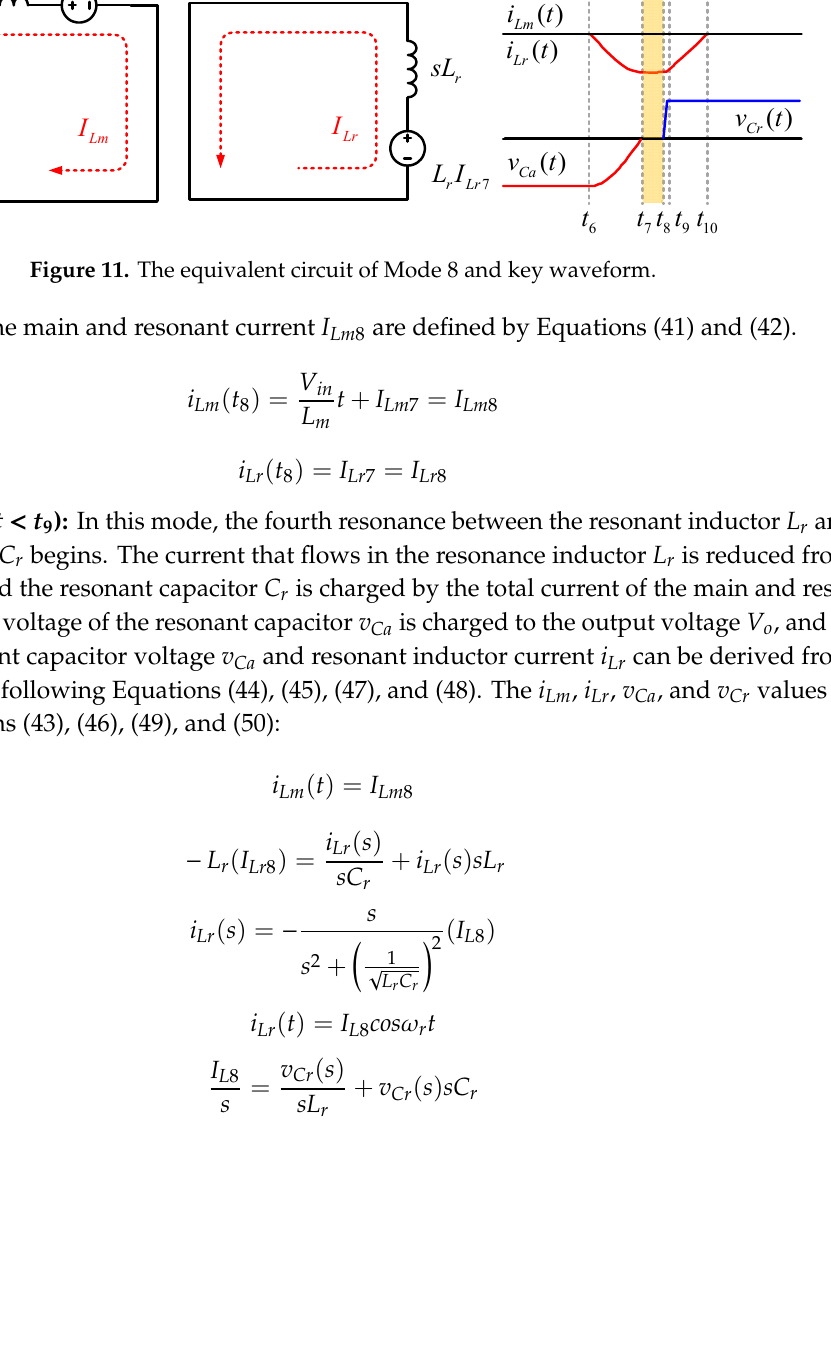
Figure 10. The equivalent circuit of Mode 7 and key waveform.